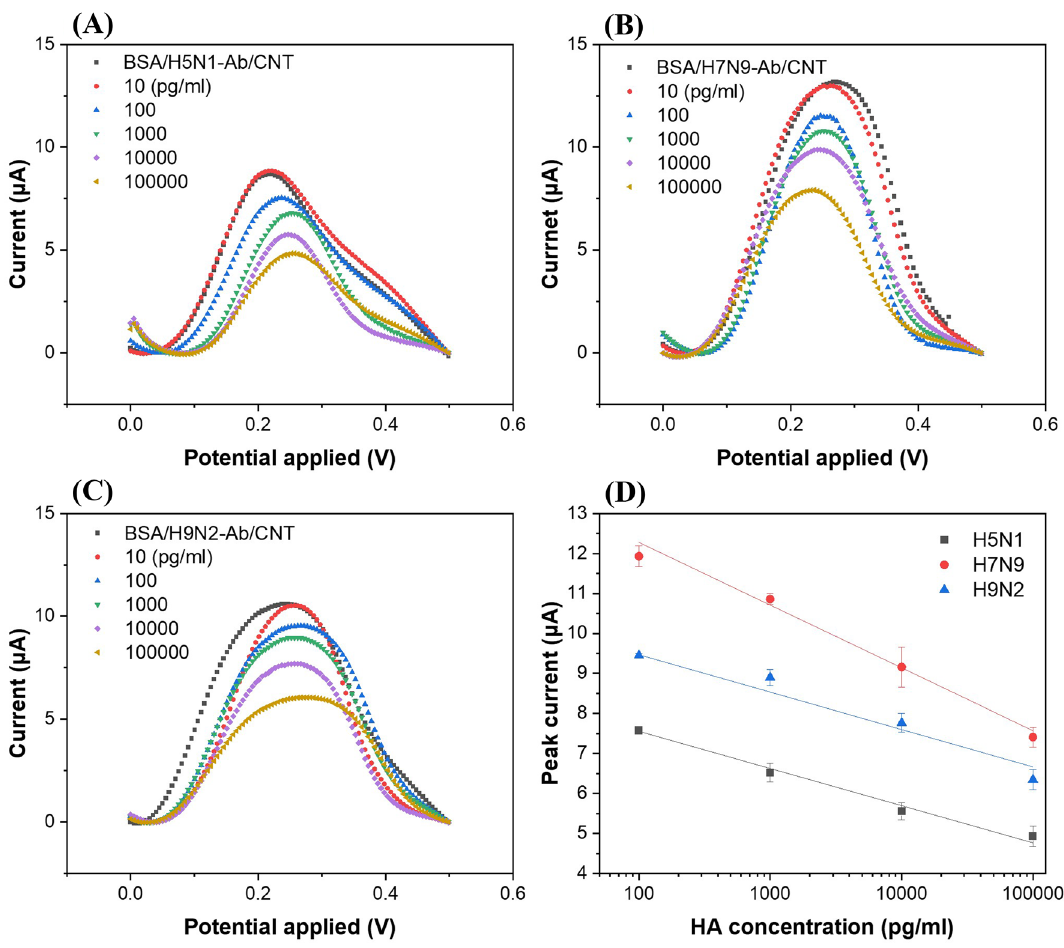
Figure 4. Differential pulse voltammograms of different concentrations of hemagglutinin antigens of the influenza virus (A) H5N1, (B) H7N9, and (C) H9N2 subtypes. (D) Calibration graphs of hemagglutinin antigens of influenza virus H5N1, H7N9, and H9N2 for the detection range from 100 pg/ml to 100 ng/ml. The error bars represent the standard deviations of three independent